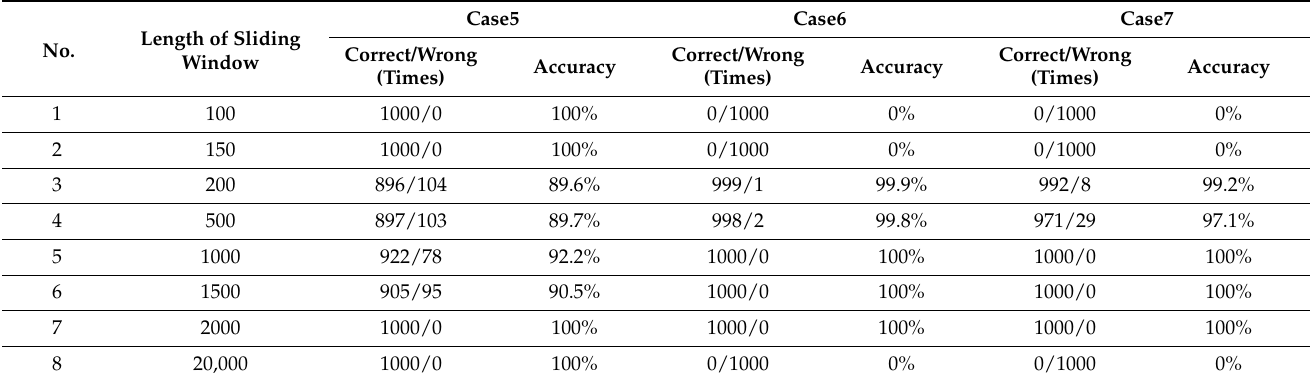
Table 2. Effect of sliding window length on detection results.